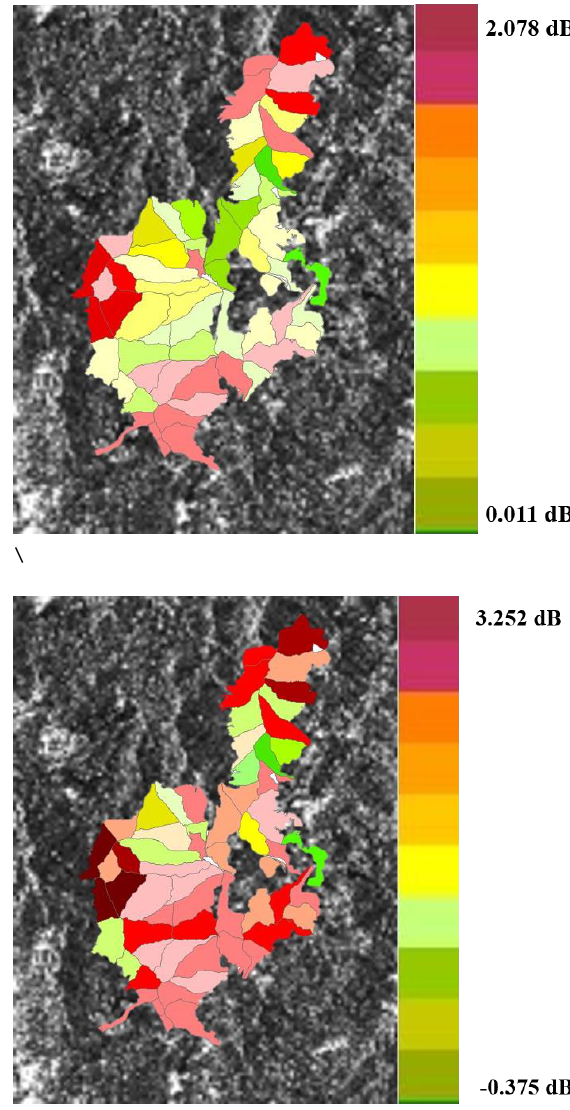
Fig. 4. The change detection images for each stand through gamma-nought (2009-2010, top; 2009-2015,